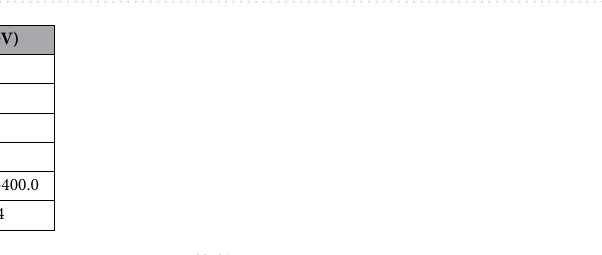
Table 2. Reference XPS binding energies of the Cu compounds 28–31